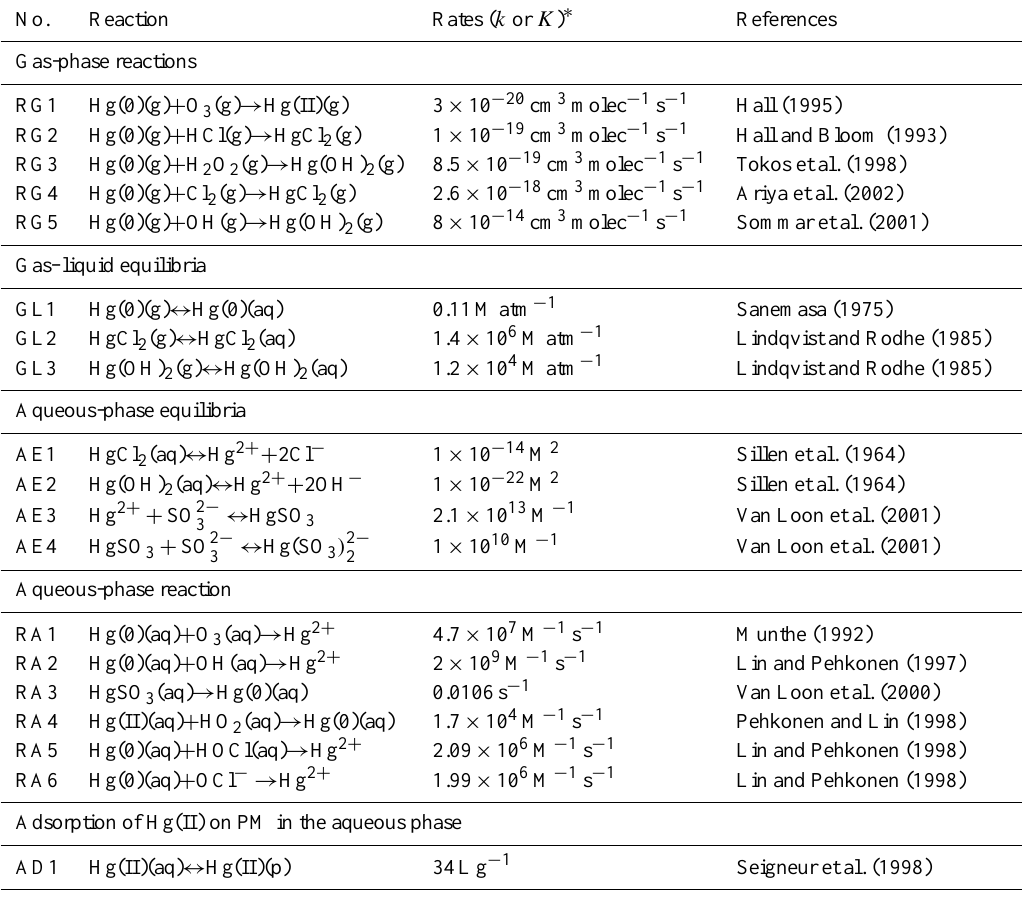
Table 1. Reactions and rate constants used in the GNAQPMS-Hg model.